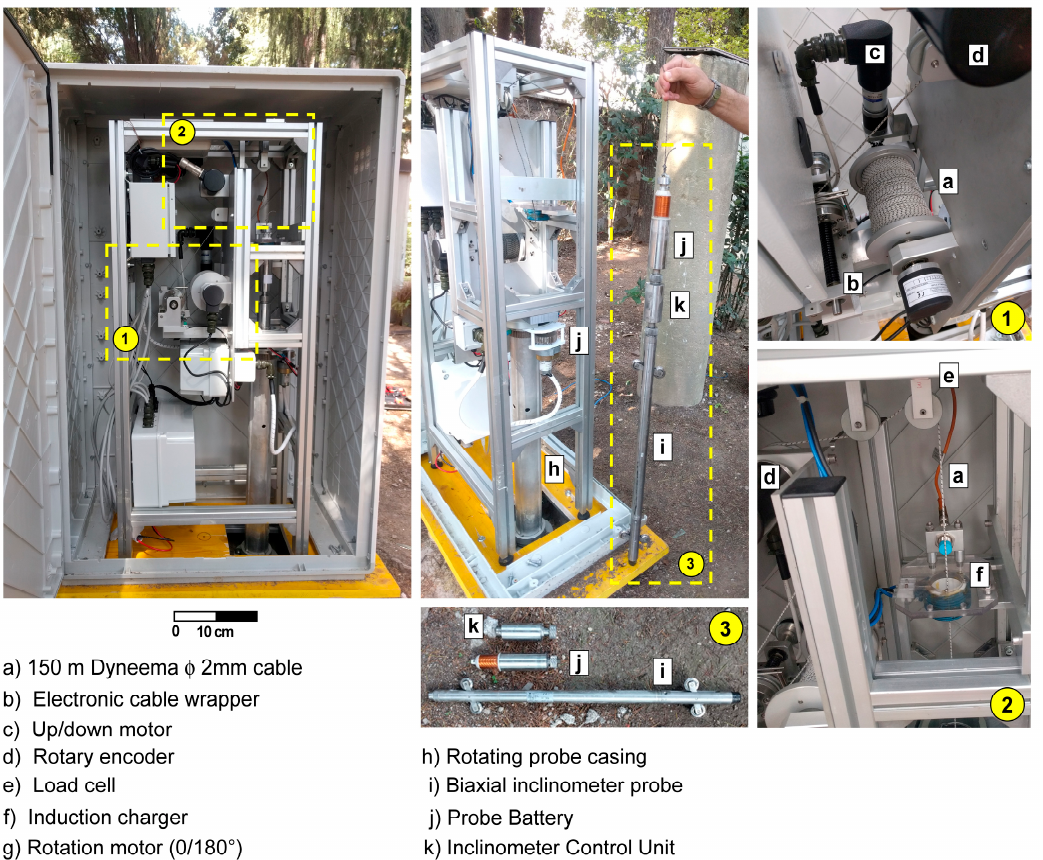
Figure 4. Main components of the Automated Inclinometer System (AIS) system realized by Italsensor Company, Pinerolo, Italy (www.italsensor.com).